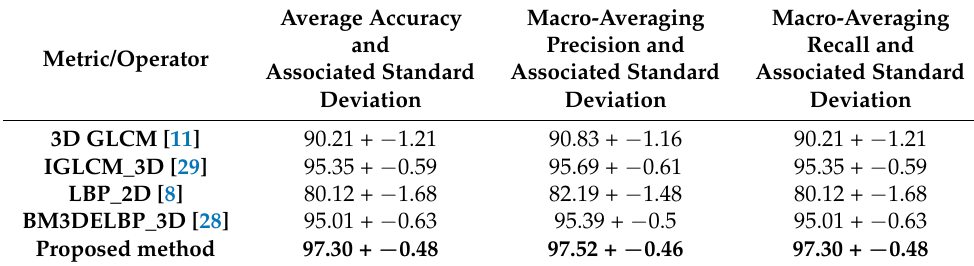
Table 9. Classification results for the second experiment with the RF classifier